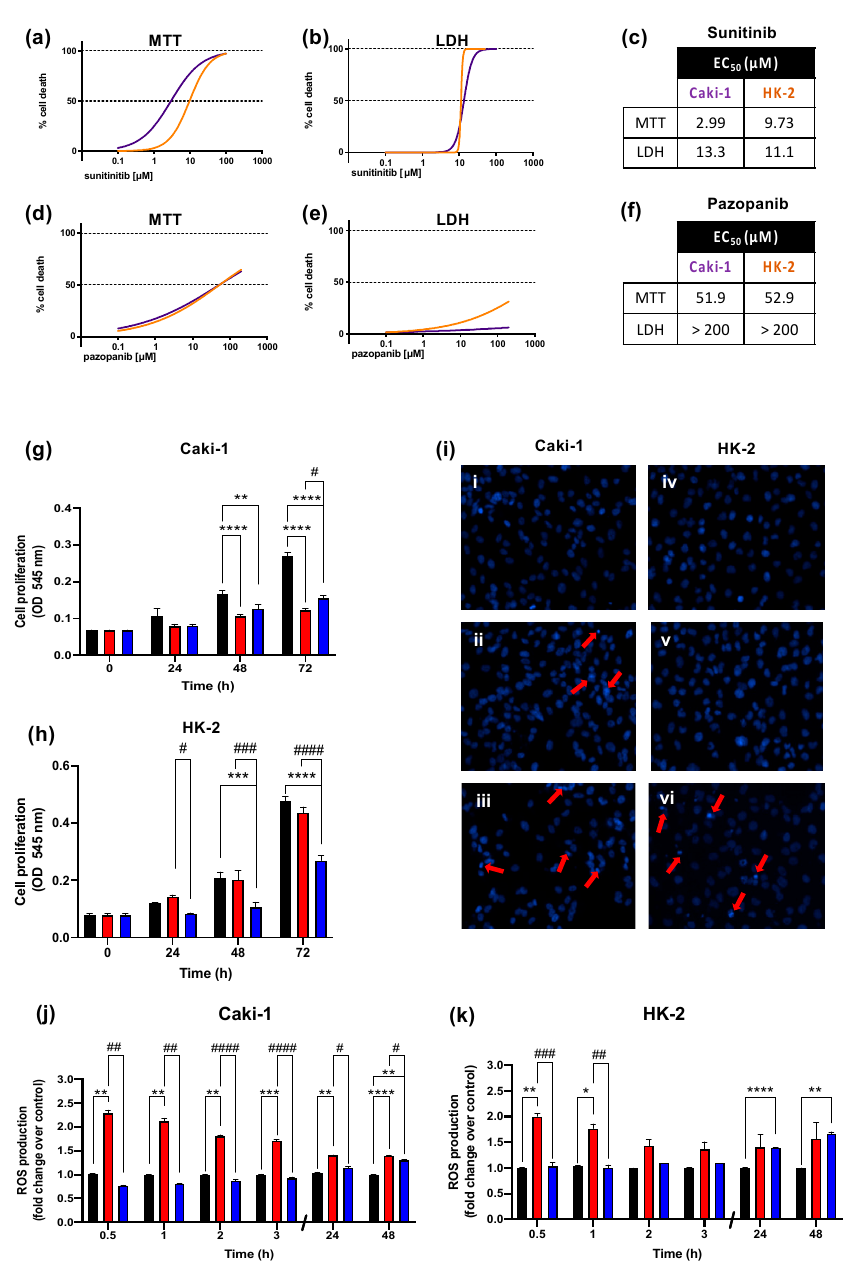
Figure 1. ( a – f ) Nonlinear regression models obtained for the cell death induced by sunitinib and pazopanib in Caki-1 (purple line) and HK-2 (orange line) cells, as evaluated by the MTT and LDH assays after 48 h exposure. ( g , h ) Inhibitory effect on proliferation of Caki-1 and HK-2 cells (black bars are non-exposed cells) exposed to 2 µM sunitinib (red bars) or 50 µM pazopanib (blue bars) after 24, 48, and 72 h, respectively. ( i ) Representative fluorescence microscopy images of Hoechst 33342/PI double staining of control ( i/i ) non-exposed Caki-1 cells, ( i/ii ) Caki-1 cells exposed to 2 µM sunitinib, ( i/iii ) Caki-1 cells exposed to 50 µM pazopanib, ( i/iv ) non-exposed HK-2 cells, ( i/v ) HK-2 cells exposed to 2 µM sunitinib, and ( i/vi ) HK-2 cells exposed to 50 µM pazopanib, for 48 h. Red arrows indicate early apoptotic cells (blue condensed nuclei). Original magnification ×200. ( j , k ) ROS production in Caki-1 and HK-2 cells (black bars are non-exposed cells) exposed to 2 µM sunitinib (red) or 50 µM pazopanib (blue) for 48 h, respectively. Results were obtained from three independent experiments, performed in triplicate, and are presented as mean ± standard error of the mean. * p < 0.05, ** p < 0.01, *** p < 0.001, and **** p < 0.0001 for sunitinib- or pazopanib-exposed cells vs. non-exposed cells. # p < 0.05; ## p < 0.01; ### p < 0.001; and #### p < 0.0001 for pazopanib- vs. sunitinib-exposed cells.